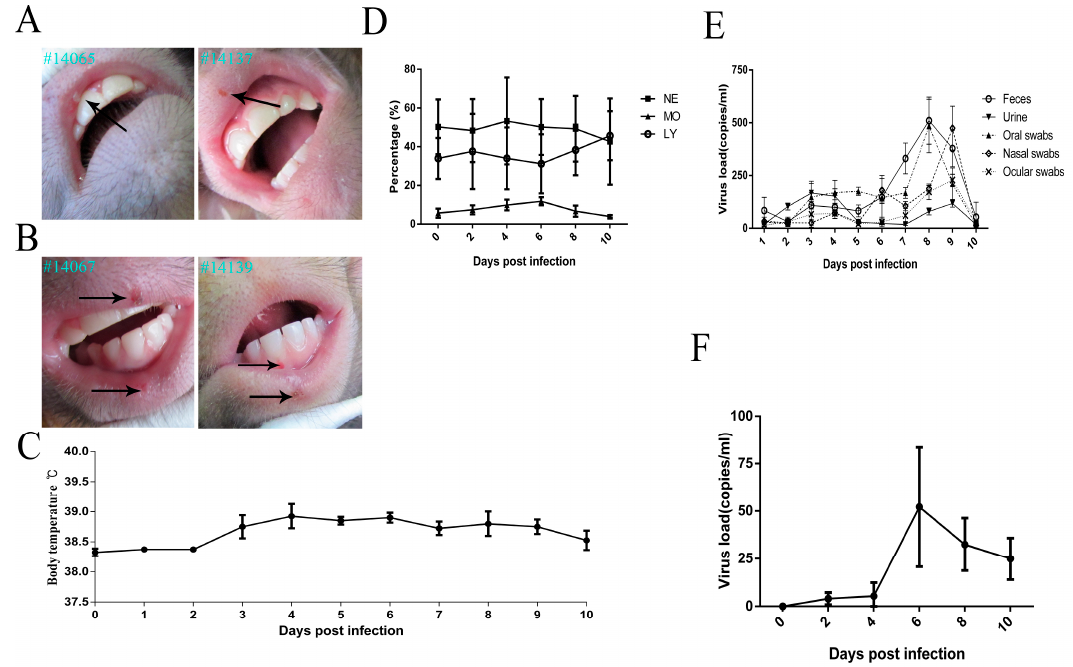
Figure 1. Clinical observation of herpes simplex virus type 1 (HSV1)-infected rhesus macaques. ( A ) vesicle in oral mucosa of macaques, indicated by black arrows; ( B ) multi-vesicles in oral mucosa of macaques, indicated by black arrows; ( C ) body temperatures of infected monkeys were measured by the anal route twice each day post-infection; ( D ) hematological analyses of lymphocytes (LY), monocytes (MO), and neutrophils (NE) from infected macaques; ( E ) feces, urine, oral swabs, nasal swabs and ocular swabs were collected continuously for 10 days after infection and detection of virus shedding. Oral swabs, nasal swabs, ocular swabs and feces indicated the total volume of the eluate; and ( F ) blood samples were collected and assessed for viral load.